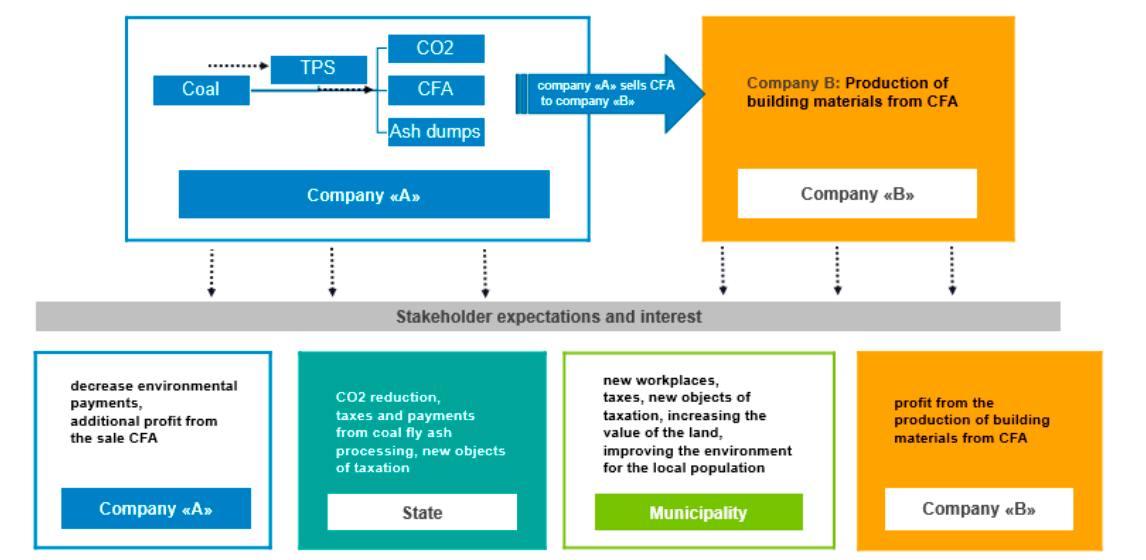
Figure 3. Recycling scenario within the scope of the CFA production company. Source: designed by authors.